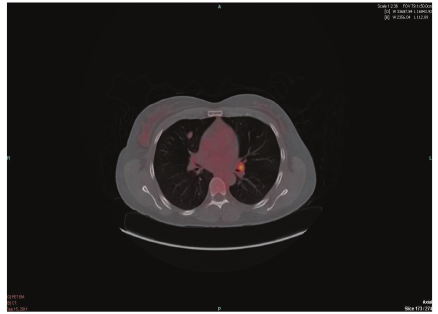
Figure 1: PET CT of chest.